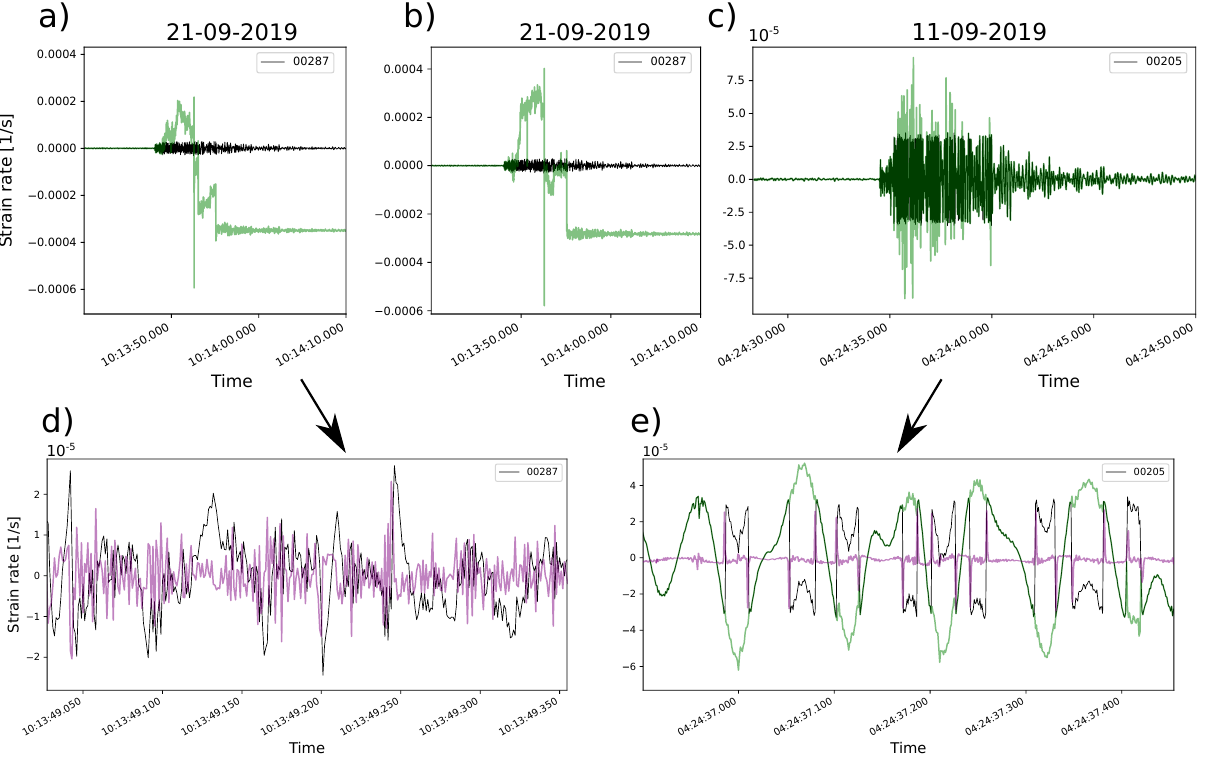
Figure 10. Signal saturation correction applied to single-channel signals for: ( a ) stack instance five, ( b ) fiber instance one (stack instance one), and ( c ) engineered fiber. Sub-figures ( d , e ) show zoomed sections of ( a , b ), respectively. Black curves are the raw signal, green curves are the corrected signals, and purple curves are the characteristic function (CF) previously defined in Section